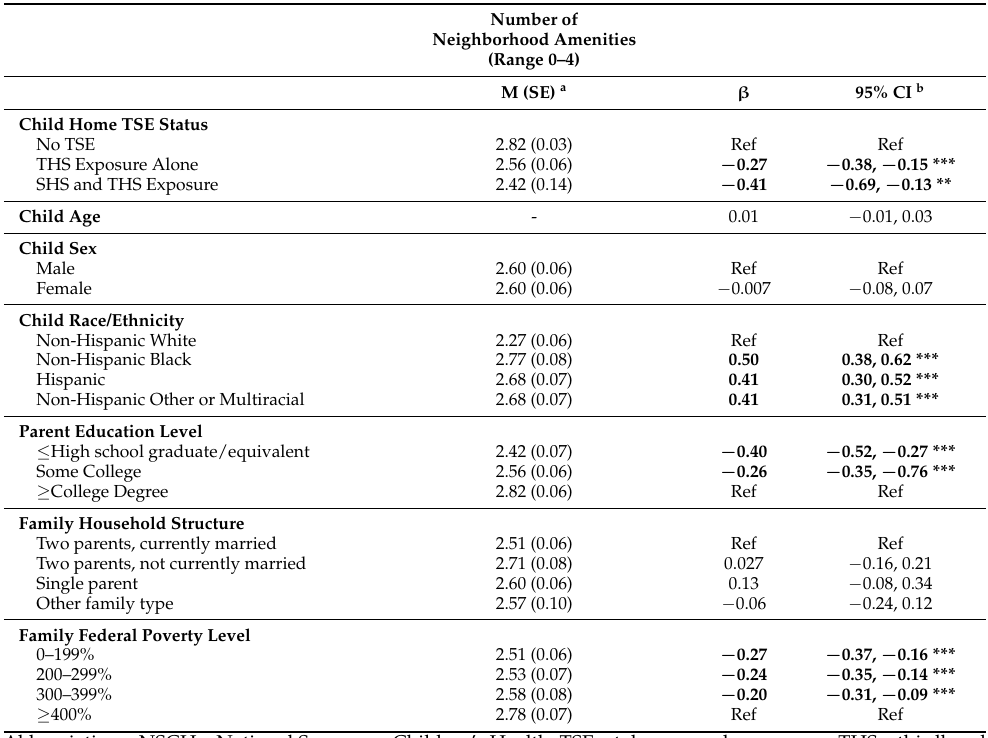
Table 2. Child home TSE status and total number of neighborhood amenities among U.S.